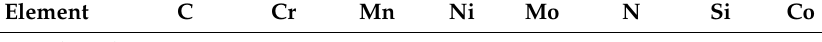
Table 1. Elemental composition of UNS S32205 (DSS 2205) reinforcing bar (wt.%), Fe balance. Element C Cr Mn Ni Mo N Si Co Ti Content (wt.%)